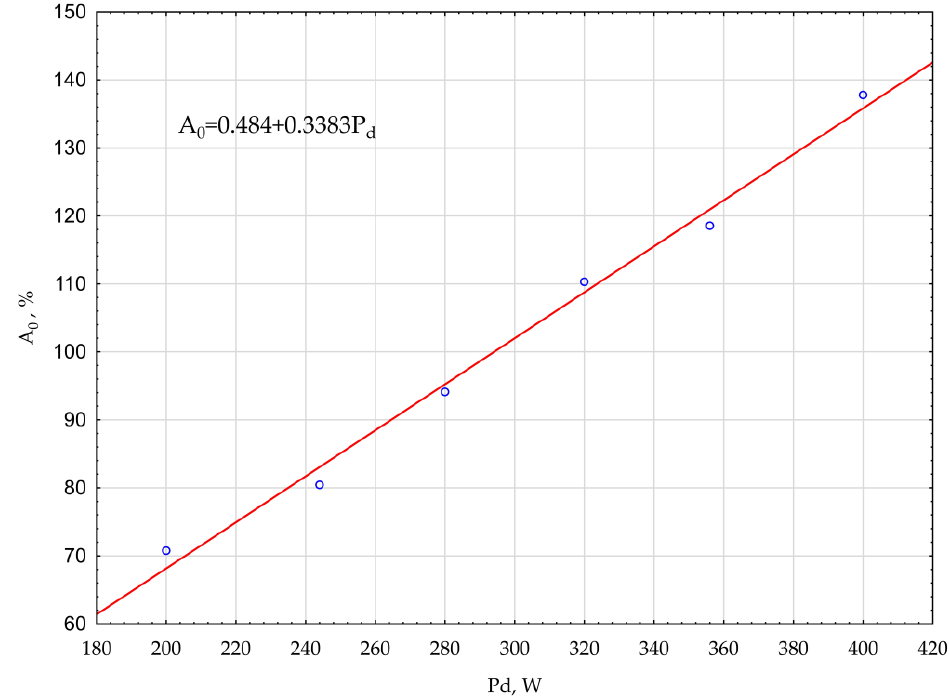
Figure 6. Dependence of the vibration amplitude of the rotary ultrasonic sonotrode on the declared power of the ultrasonic generator.